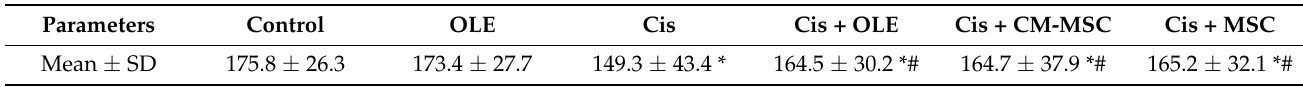
Table 8. The mean and standard deviation (SD) of the optical density of PCNA immunoreaction activity in the spleen in the different experimental groups.